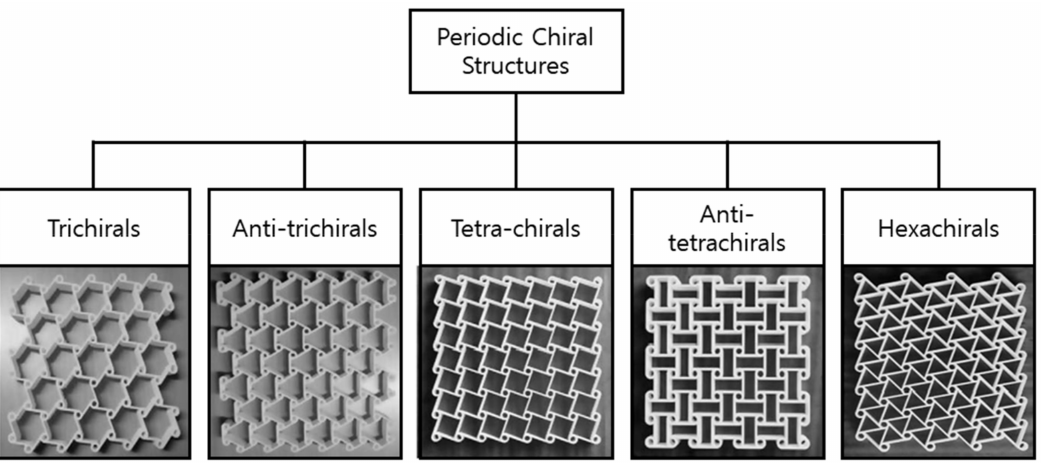
Figure 17. Classification and representative structures of periodic chiral structures